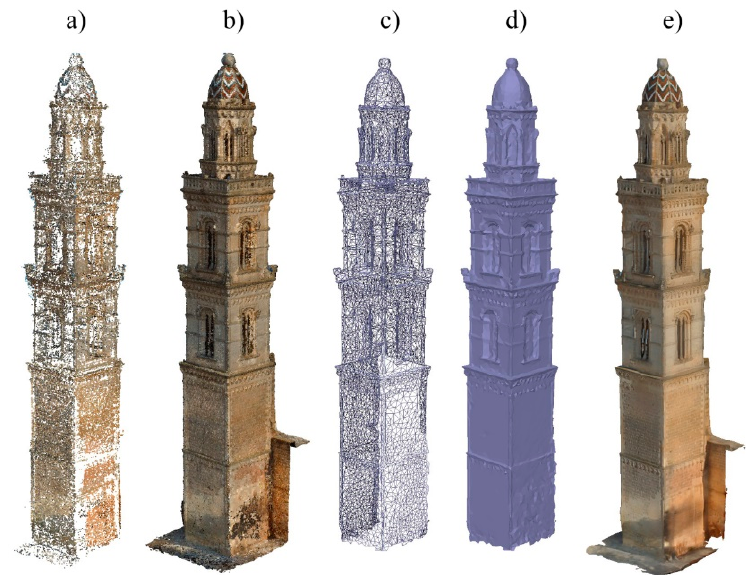
Figure 6. Computer graphical elaboration of the bell-tower: ( a ) point cloud, ( b ) dense cloud, ( c ) wireframe, ( d ) mesh, ( e ) textured.